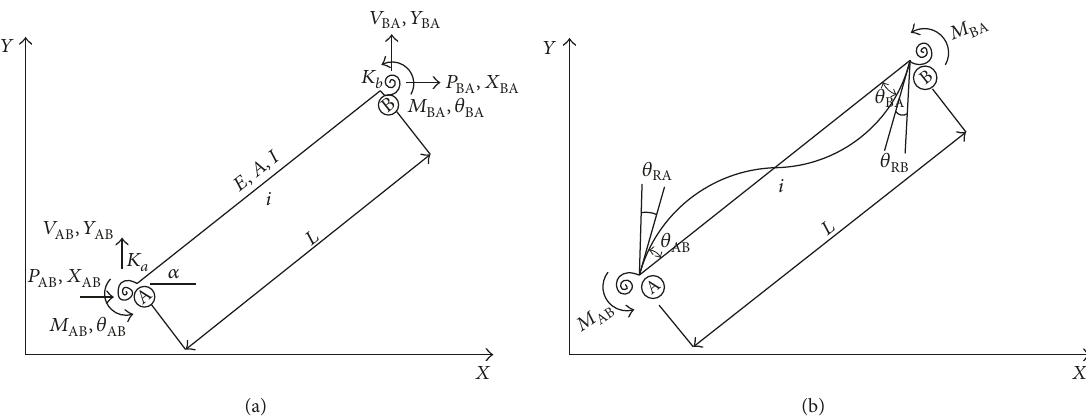
Figure 2: (a) Forces and displacements and (b) rotations in the semirigid frame